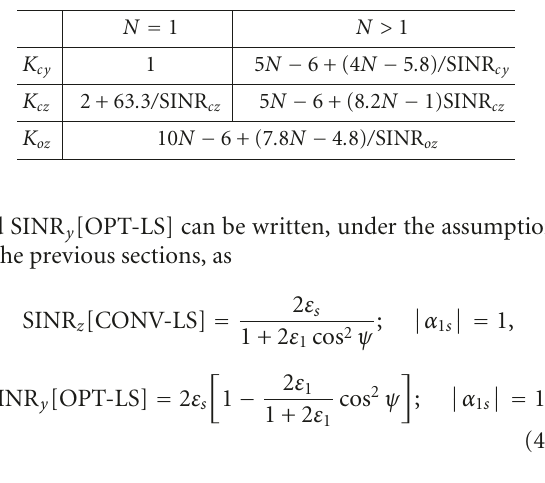
Table 1: K cy , K cz , and K oz as a function of N and SINR y